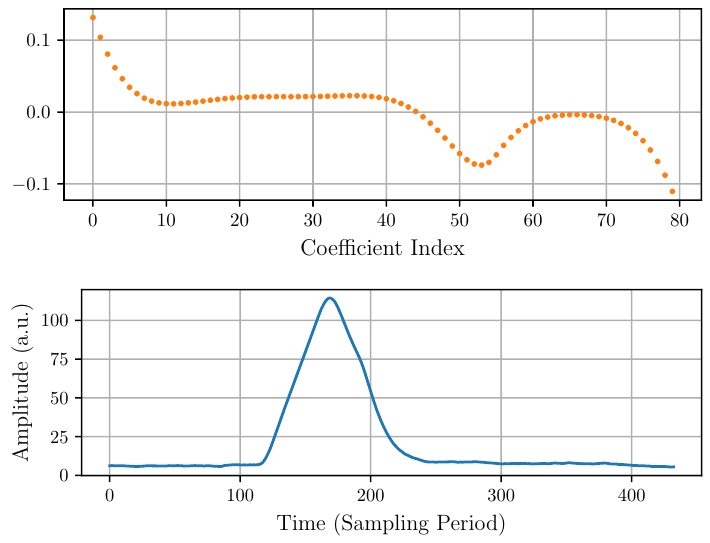
Figure 11. DPLMS FIR coefficients ( top ) and the corresponding output after being applied to an experimental pulse ( bottom ).